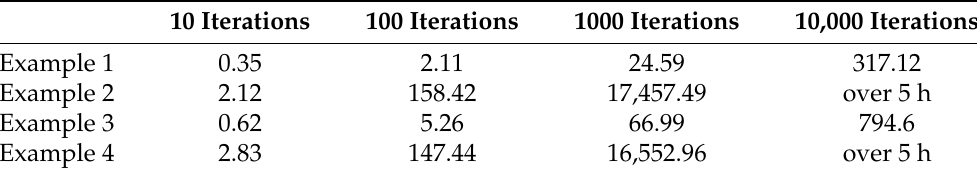
Table 8. Computing time in